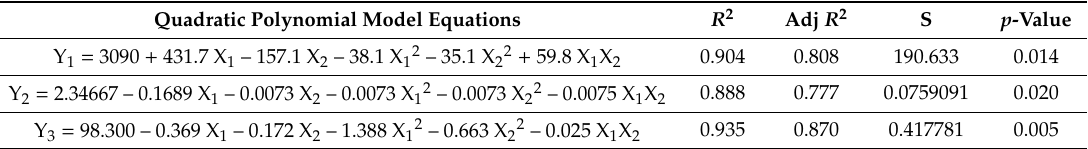
Table 3. Response surface model equations for monitoring the e ff ects of thermal treatment on the physical properties of CAG